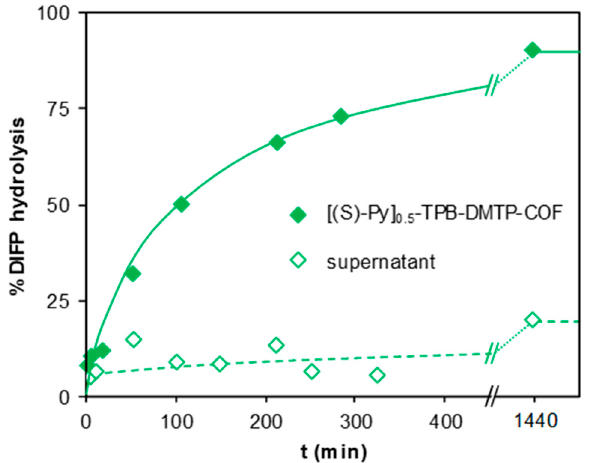
Figure 4. Filtration test to confirm the heterogeneous nature of the DIFP degradation process by [( S )-Py] 0.5 -TPB-DMTP-COF in unbuffered aqueous solution. DIFP degradation profile in the presence of [( S )-Py] 0.5 -TPB-DMTP-COF (solid diamonds) and supernatant solution after the filtration of the catalyst (open diamonds).